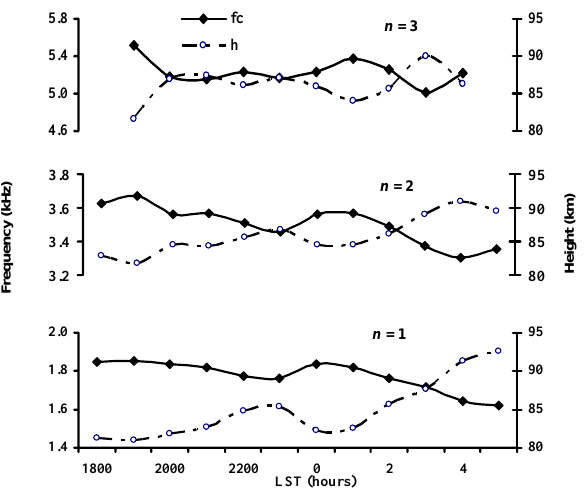
Fig. 5. Temporal variation of mean cut-off frequency, f cm , (solid line, left hand scale) and reflection height, h m , (dashed line, right hand side) determined using 1-3 harmonics of tweeks.